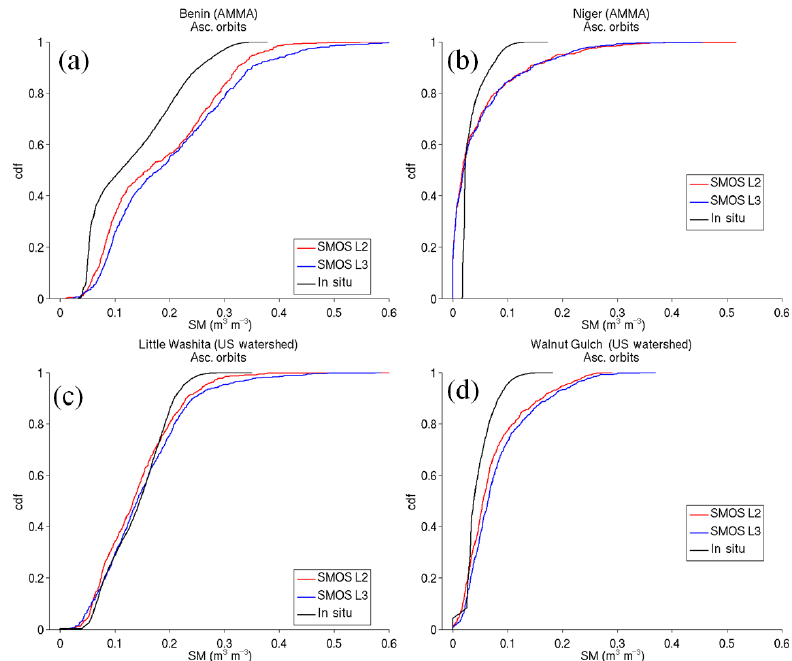
Figure 13. Cumulative distribution function (CDF) for the validation sites for ascending overpasses.